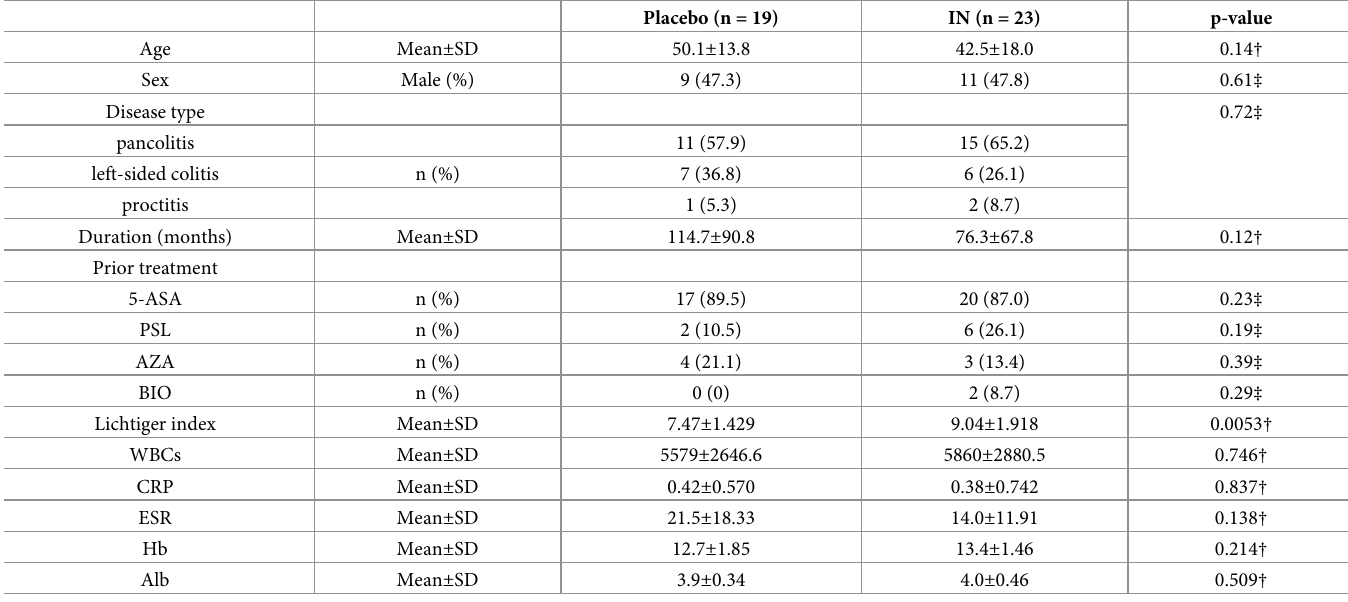
Table 1. Baseline characteristics.